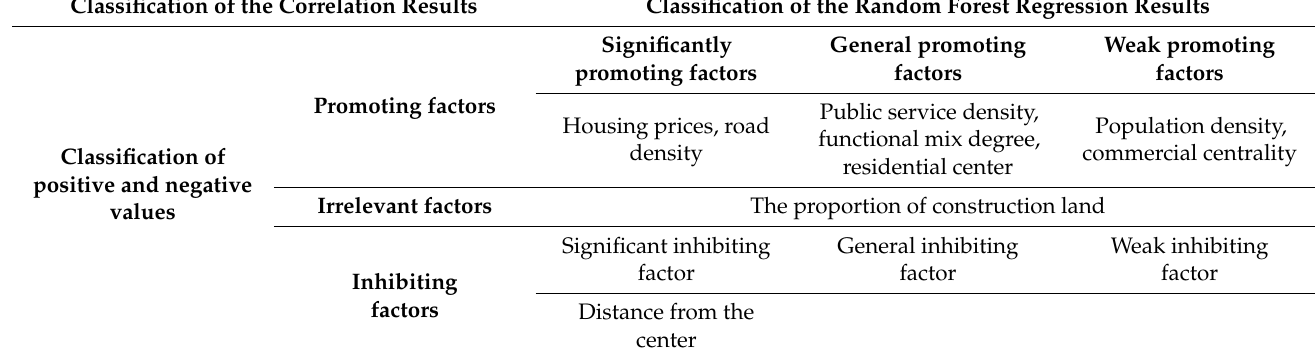
Table 5. Classification of the influencing factors.